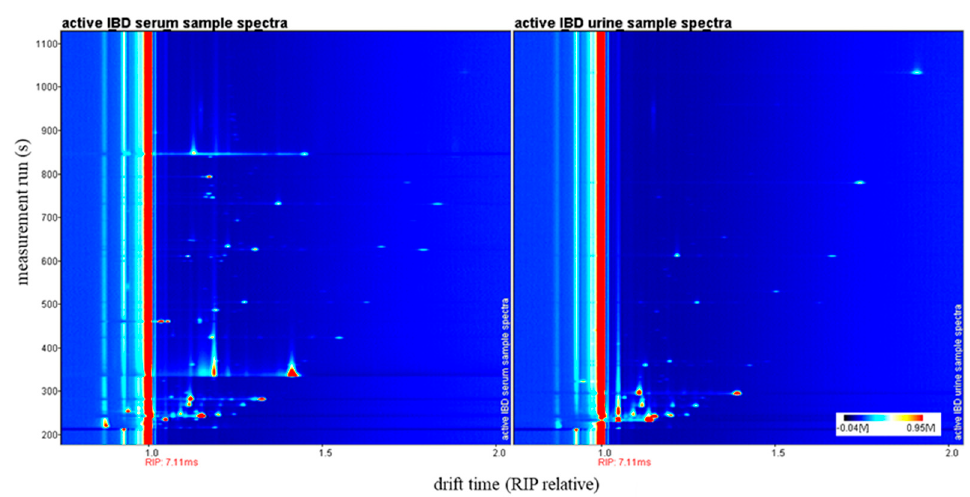
Figure 2. Comparison of topographic plots of serum and urine sample spectra from an active IBD